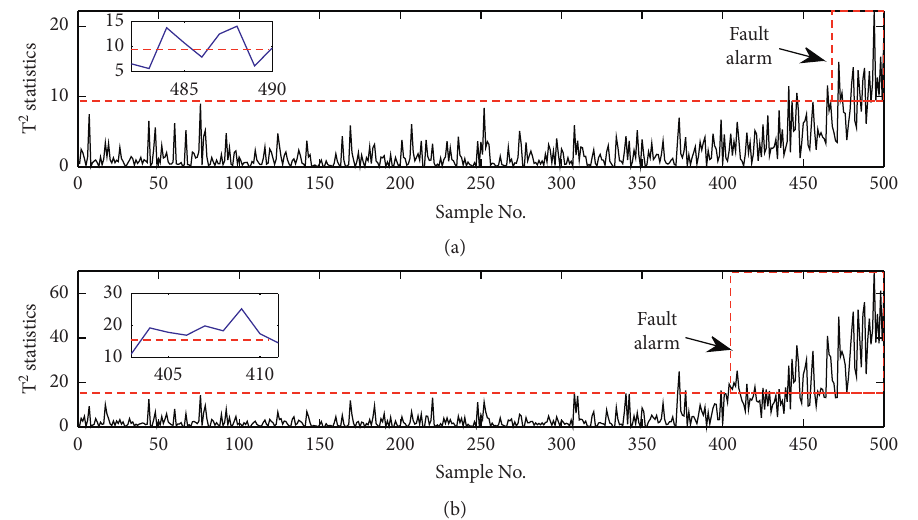
Figure 6: (a) Conventional Hotelling’s T 2 control chart. The redline is UCL of 9.62. (b) An improved dual-kurtogram-based T 2 control chart. The redline is UCL of